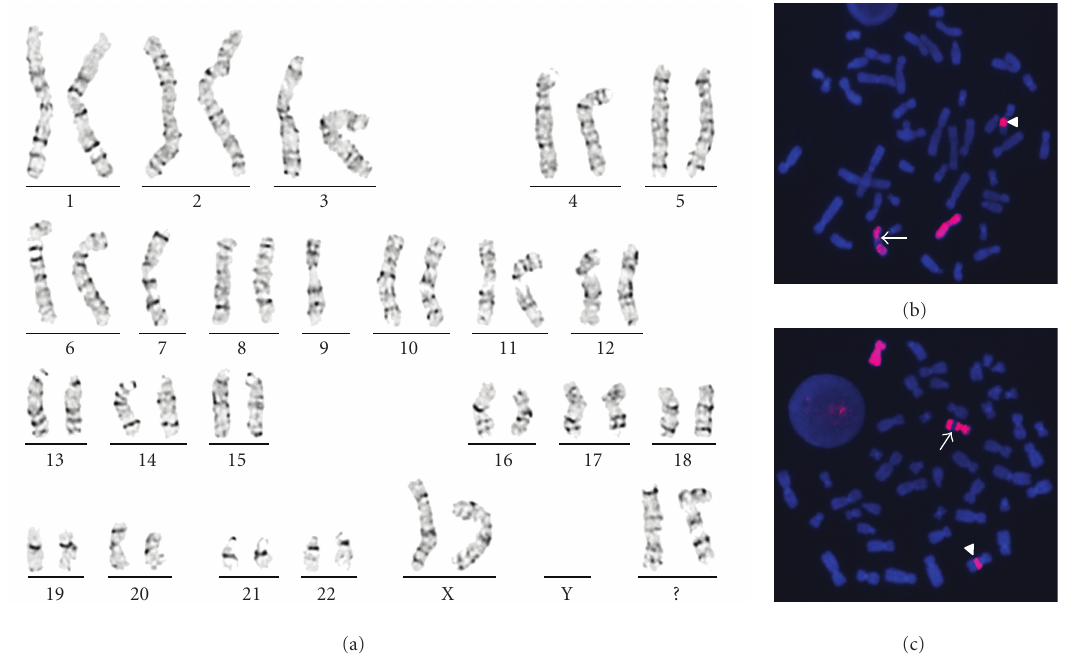
Figure 5: Chromosome abberation in a 6-year-old female with mental retardation (MR). High-resolution GTG-banding in Figure 5(a) revealed the derivative chromosomes 7 and 9 (question mark), and their detailed identities were further illustrated by the results of FISH analysis. Figure 5(b) showed four red signals in a metaphase, by means of utilization of whole chromosome 7 painting probe (WCP 7, red). The normalchromosome 7 had one intact red signal,but the derivative chromosome 7 (arrow) had two dispersed red signals, and a fragment of chromosome 7(arrowhead) was inserted into a chromosome 9, forming a derivative chromosome 9. Similarly, FISH analysis with WCP 9 (red) in Figure 5(c) showed the normal chromosome 9 with intact red signal, the derivative chromosome 9 (arrow) with two dispersed red signals, and the derivative chromosome 7 with a inserted fragment of chromosome 9 (arrowhead). Finally, the chromosome karyotype in this patient was identified as 46, XX, ins (7;9) (p13; q32q22) inv(7) (p11.2 q11.23), ins (9;7) (q22; q22q32), ish ins(7;9) (WCP7+,